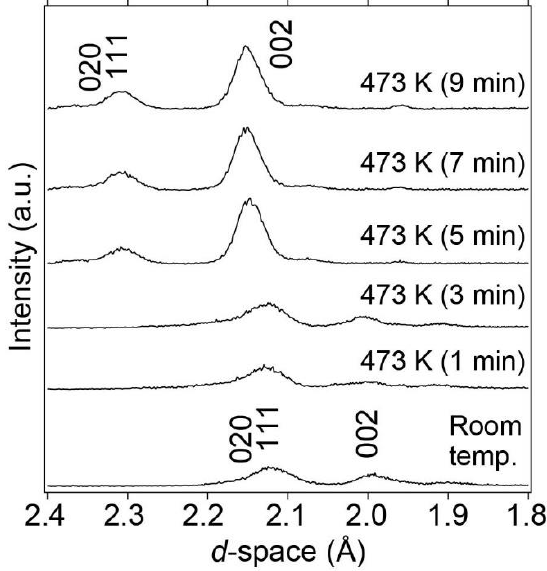
Figure 3. Synchrotron radiation X-ray diffraction patterns of LaNi 5 at 473 K and 1.6 GPa focusing on Bragg peaks of the (020), (111), and (002) reflections.